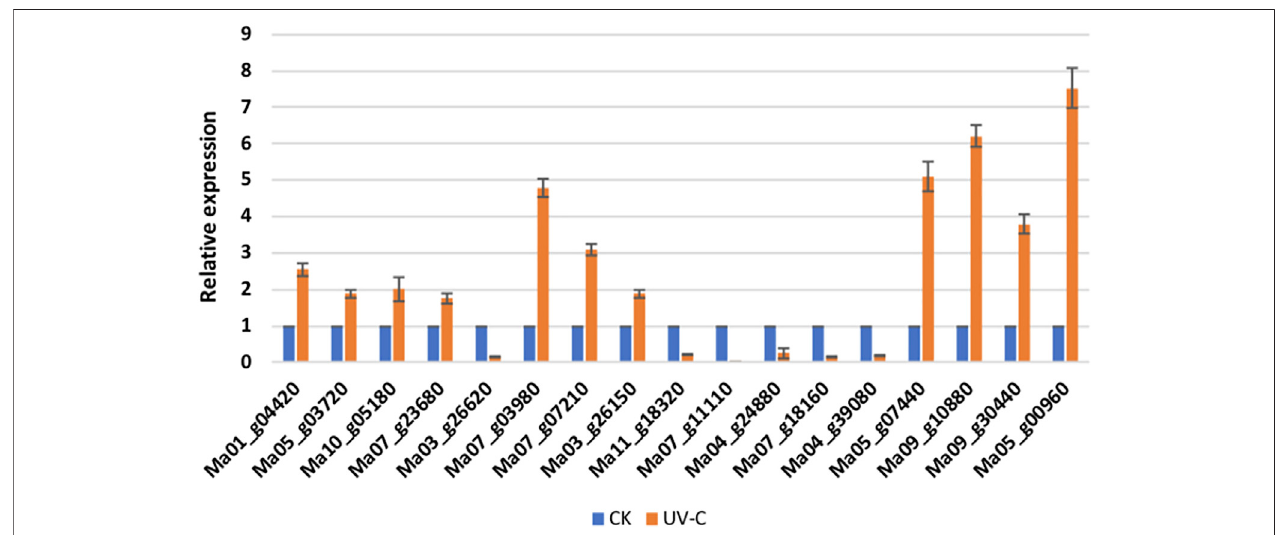
FIGURE 6 | qRT-PCR analysis of selected M. nana genes that were differentially expressed in UV-C treated peels (UV-C) as compared to control (CK). The error bars on columns represent the standard